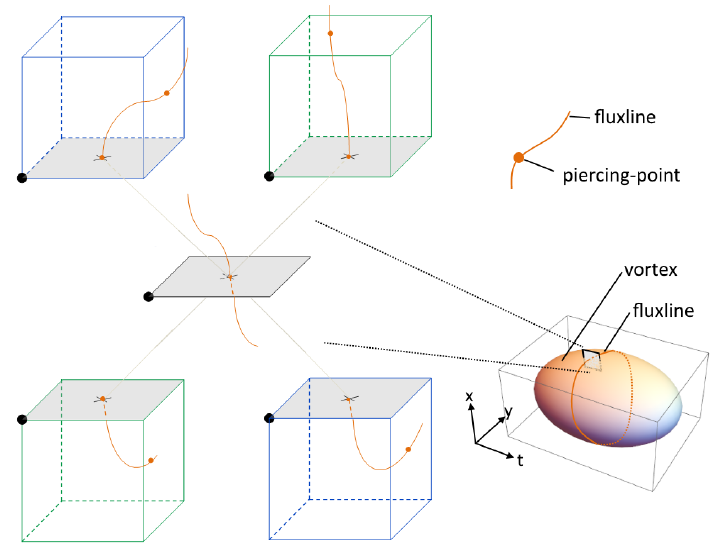
Figure 2. A closed color magnetic flux evolving in time creates a closed surface in four dimensional spacetime. On the lattice a flux piercing a plaquette has to be traceable through the four attached